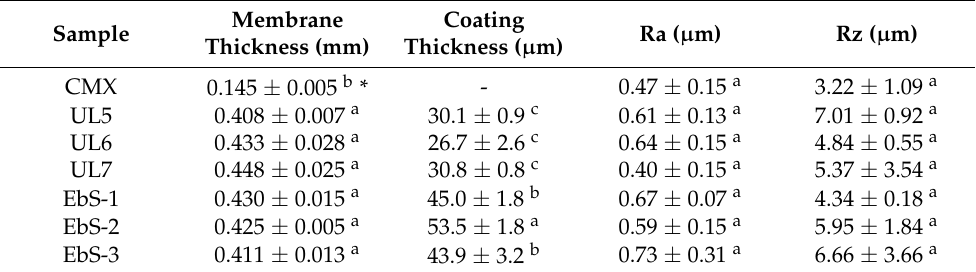
Table 2. hIEMs and commercial reference membranes’ thickness, Ra and Rz, and hIEMs coating layer thickness.